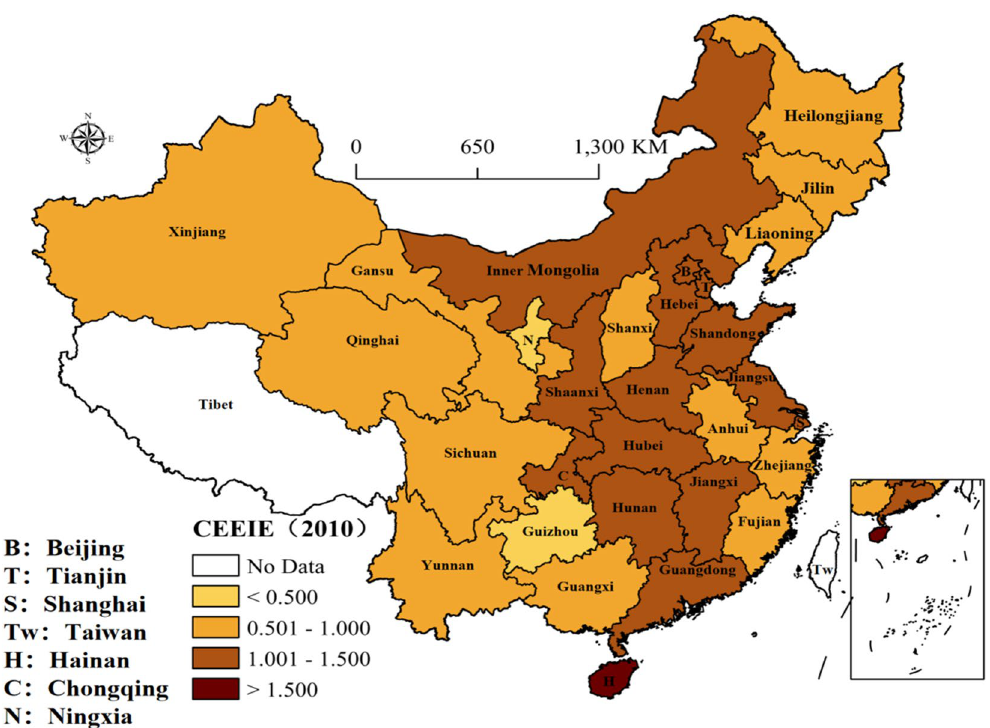
Figure 3. The distribution of CEEIE in 2010 (prepared by KL in ArcGIS Pro, https:// www. esri. com/ zh- cn/ arcgis/ produ cts/ arcgis- pro/ resou